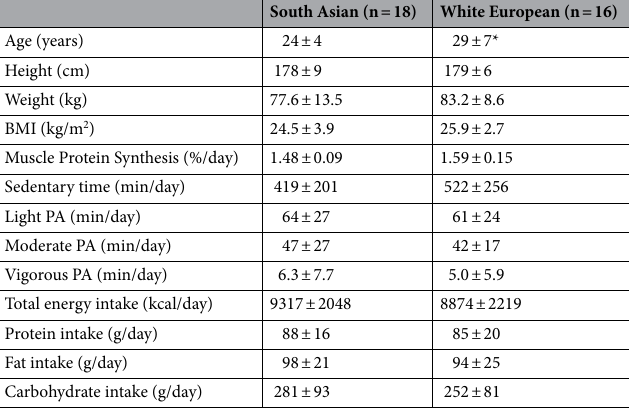
Table 1. Demographic, MPS, diet and physical activity data at baseline in south Asian and white European volunteers. Data are presented as mean (SD)* denotes a significant ( p < 0.05) difference between the groups at baseline (paired t-test).